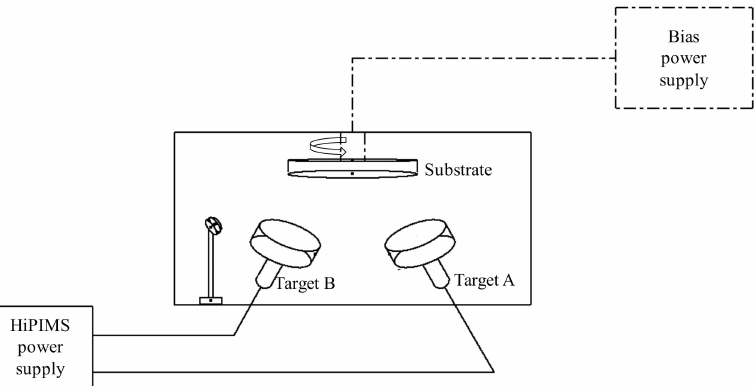
Figure 1. Schematic diagram of HiPIMS sputtering system.